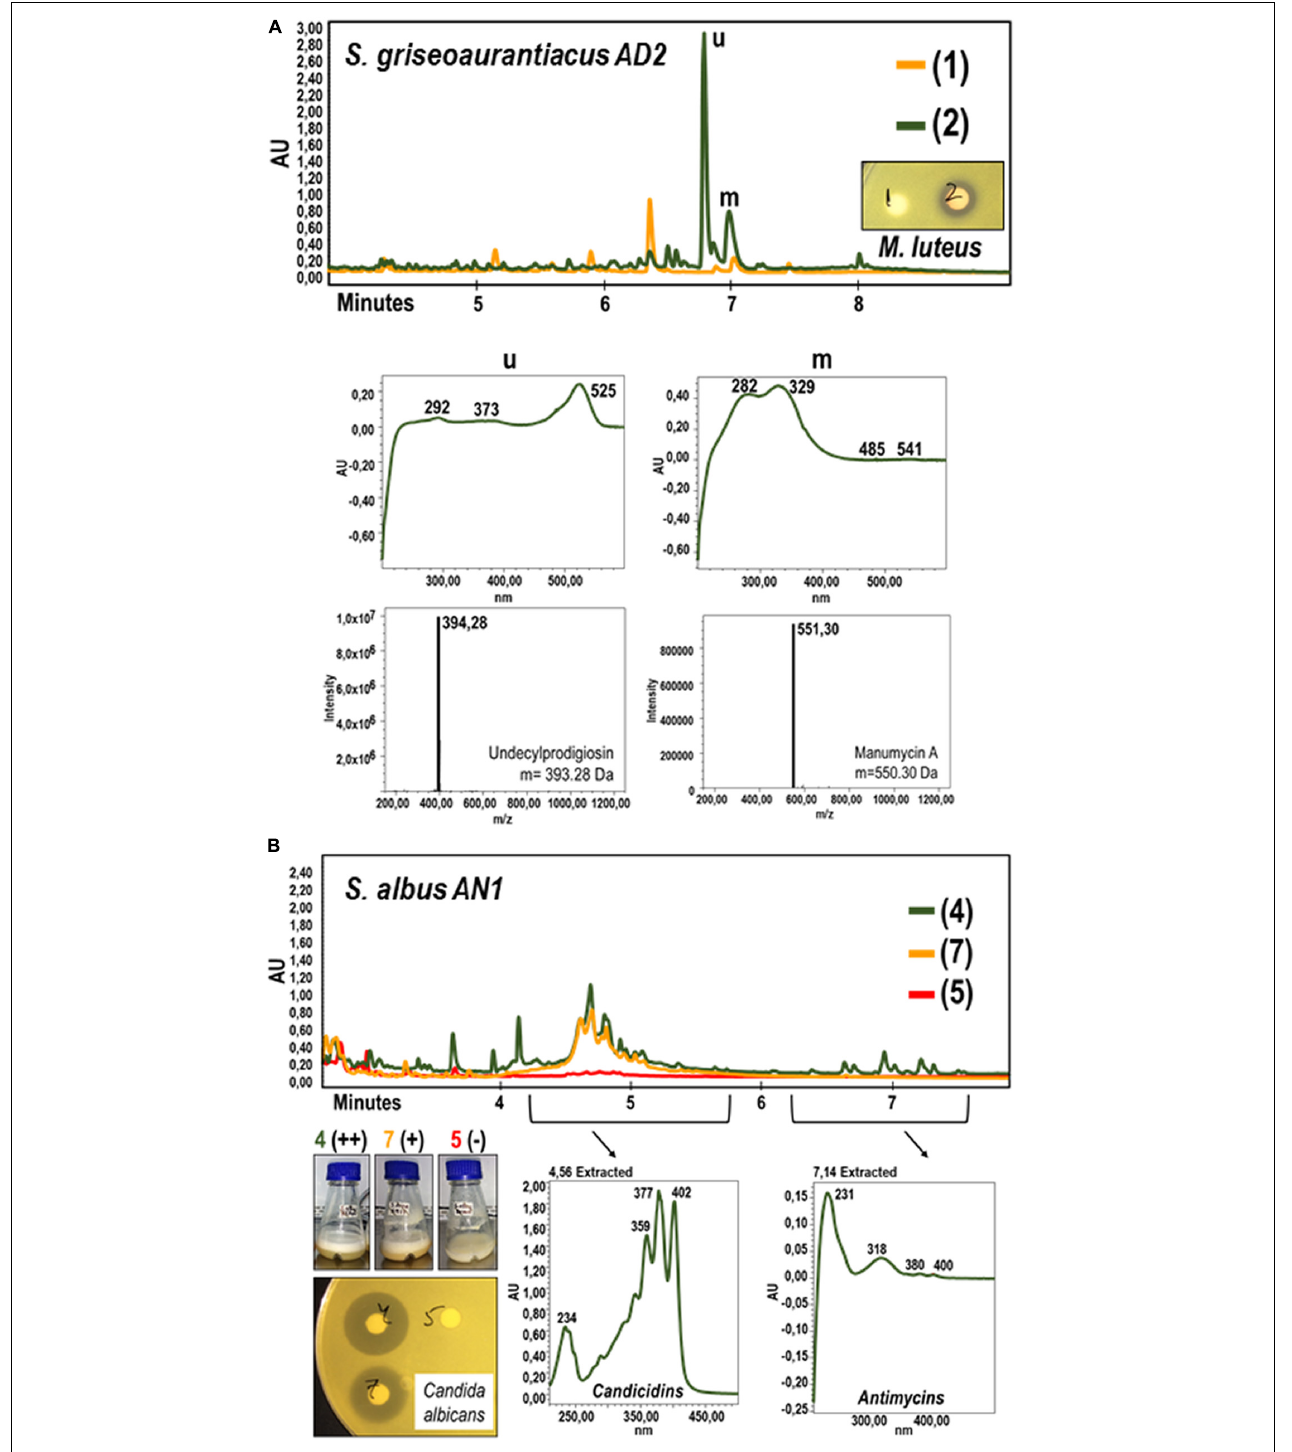
FIGURE 2 | Metabolic characterization by UPLC and LC-MS analyses of cell extracts from cultures of Streptomyces griseoaurantiacus AD2 (A) and Streptomyces albus AN1 (B) strains. (A) S. griseoaurantiacus AD2 extracts were generated from 96 h-cultures in R5A (green) or SM17 (orange), and assayed against M. luteus . The graphs below the UPLC chromatograms show the UV spectrum of the metabolites that might display antimicrobial activity (see peaks named as “u” and “m”). The corresponding molecular weights were calculated by LC-MS analyses (and also by dereplication analyses), resulting in the identification of the metabolites undecylprodigiosin and manumycin A. (B) S. albus AN1 extracts were generated from 96 h-cultures in R5A (green), SM17 (orange) and Bennet (red), and assayed against C. albicans . The peaks selected from the AN1 cultures possess an UV spectrum that match that of the candicidins and antimycins.